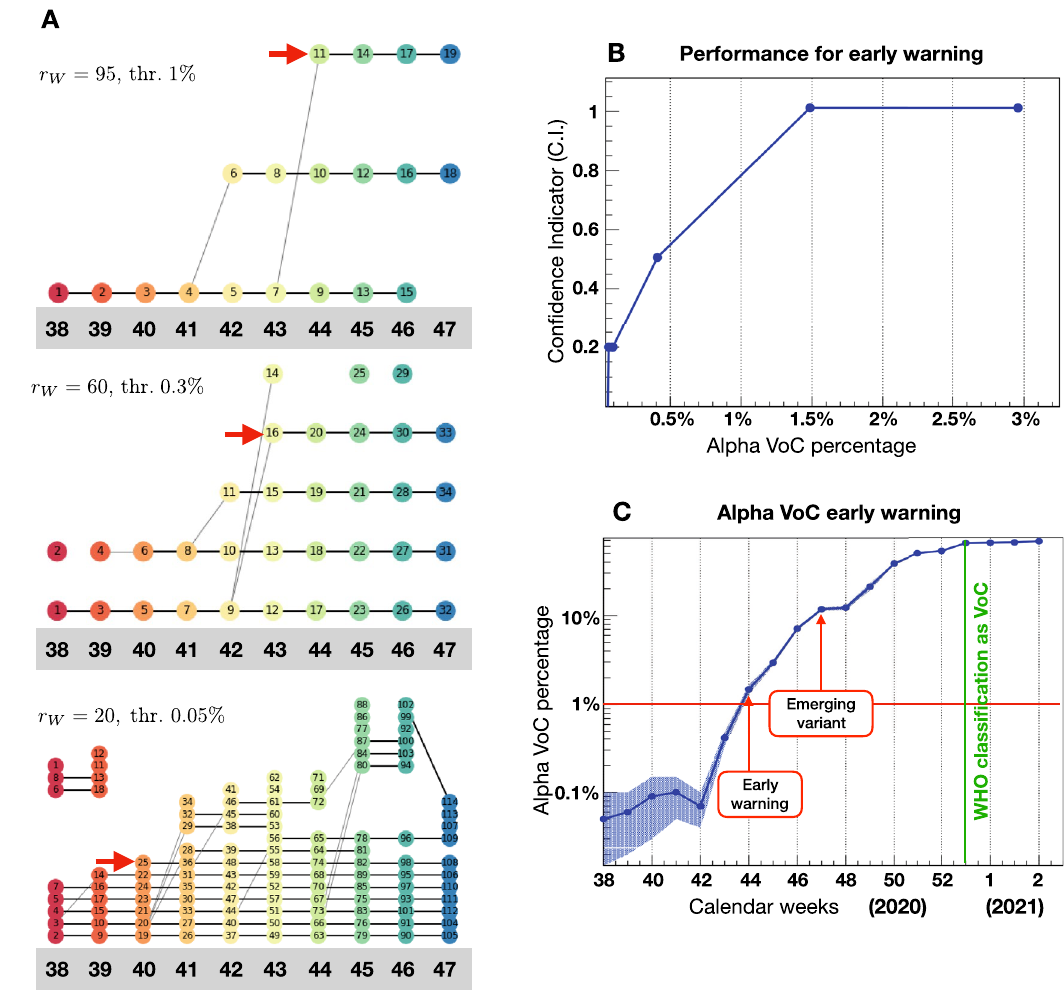
Figure 3. Early warning performance. ( A ) Cluster chains from week 38 to week 47 obtained at different working points. The chain containing the Alpha VoC Spike variant is highlighted by the red arrow. ( B ) Confidence indicator for the early warning performance as a function of the percentage of the new variant in the time-binned data. ( C ) Data for the Alpha VoC, indicating the early warning and definition of the emerging variant, using our ML on a weekly binning, compared to the time of the WHO classification as